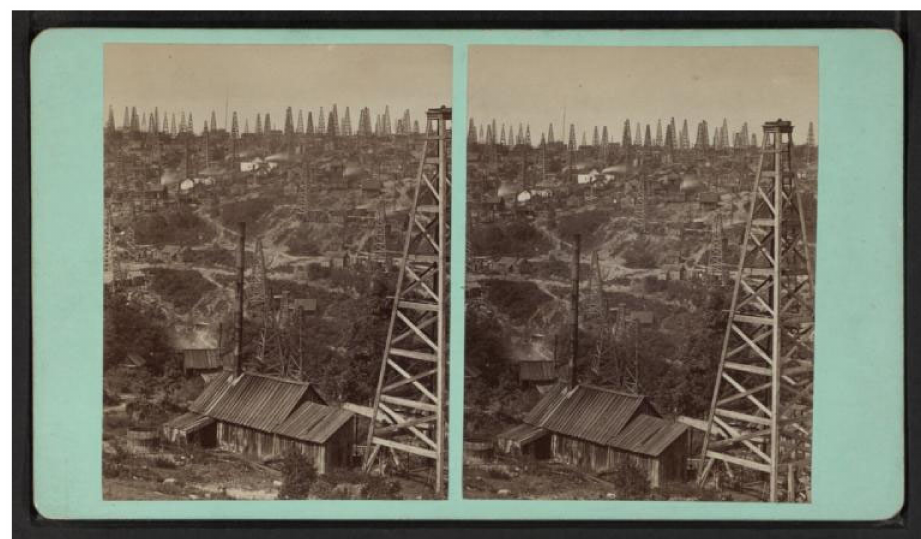
Figure 1. Large stereoscopic views of the Pennsylvania oil region. Eastside, Triumph Hill, 50 derricks, by Franke Robbins, in 1846. From New York Public Library, Public domain, via Wikimedia